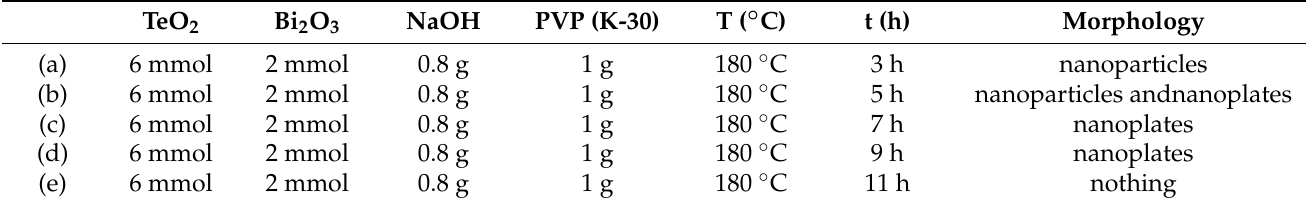
Figure 6. A series of reaction time ( a ) 3 h, ( b ) 5 h, ( c ) 7 h, ( d ) 9 h, ( e ) 11 h, ( f ) nanoplate length length size. Table 4. Influences of the reaction